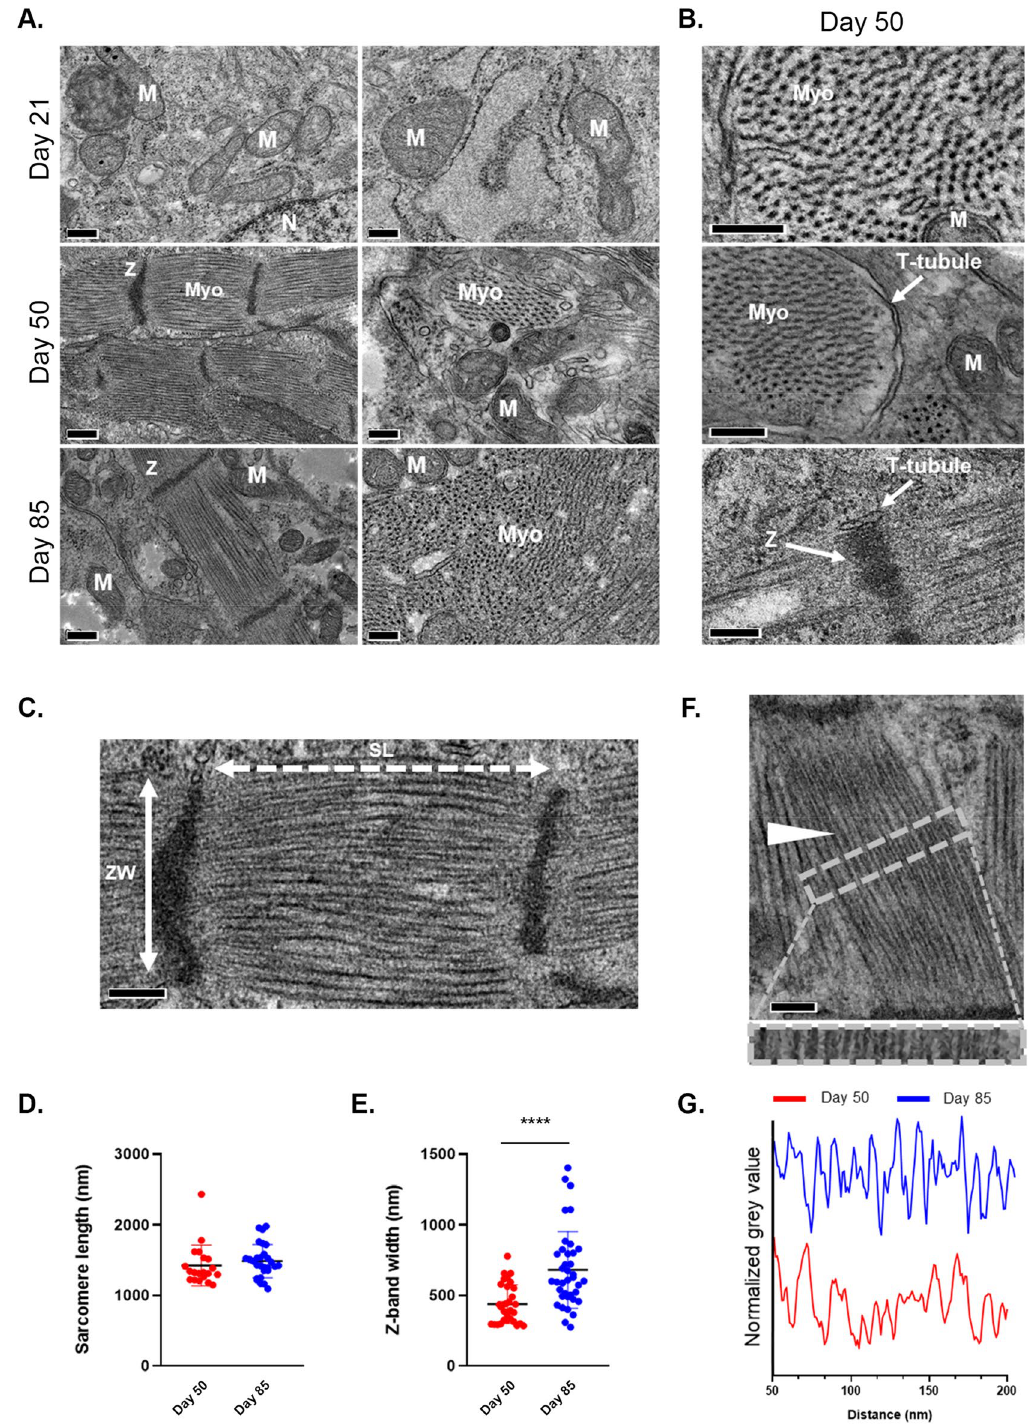
Figure 5. Ultrastructural analysis of 3D hOCMTs indicates enhanced maturation in 3D environment over time. ( A ) TEM images of 3D hOCMTs s showing increasing ultrastructural organization over time, from day 21 to day 85: Cardiomyocyte myofibers (Myo), Mitochondria (M) Z-band (Z), T-tubules. Scale bars = 200 nm. ( B ) Close-up images on day 50. Scale bars = 200 nm. ( C ) Representative micrograph showing sarcomere length (SL; white dotted two-headed arrow) and z-band width (ZW; cross sectional length; white solid two-headed arrow) with the corresponding sarcomere length ( D) ; day 50, 1400 ± 300 nm; day 85, 1500 ± 200 nm; N > 20, Mean ± SD)- and z-band width ( E ); day 50, 450 ± 100 nm; day 85 700 ± 250 nm; N > 30, Mean ± SD). Scale bar = 200 nm. ( F ) Micrograph showing myofiber organization (white arrow) with their relative organization as defined by the plot profile intensity on day 50 vs day 85 ( G ) of the area indicated by the grey dashed box of ( F ). Scale bar = 200